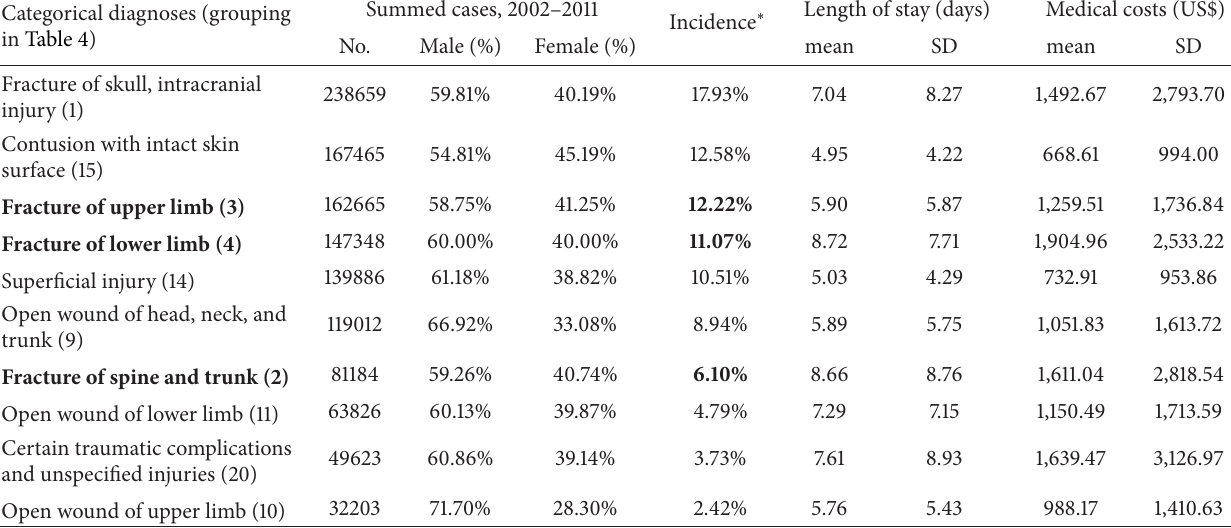
Table 2: The most 50% of admitted diagnoses related to traffic incidents and their effects on the medical utilizations. Categorical diagnoses (grouping